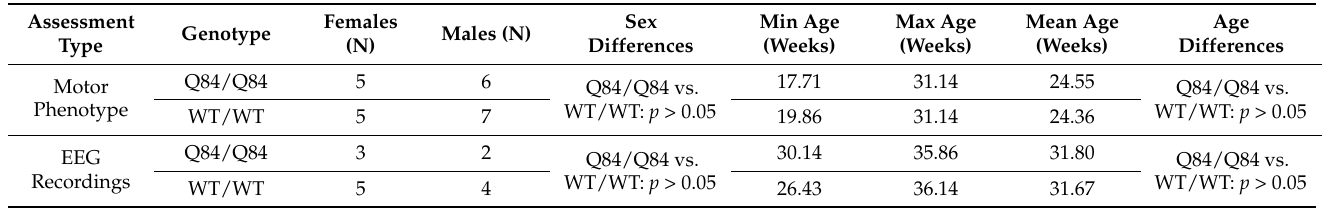
Table 1. Sex and age of homozygous Q84/Q84 and wild-type WT/WT mice used for motor assess- ment and EEG recordings.